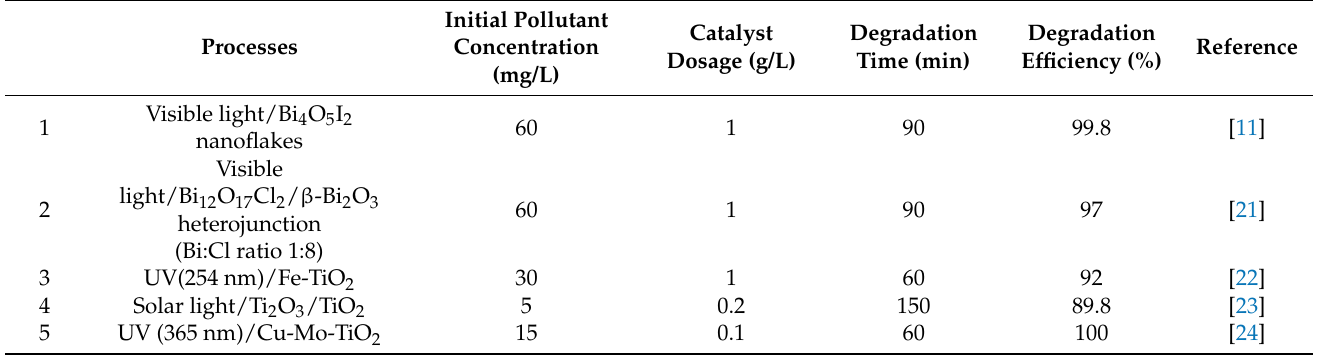
Table 1. Application of different AOPs for 4-t-BP degradation in recent